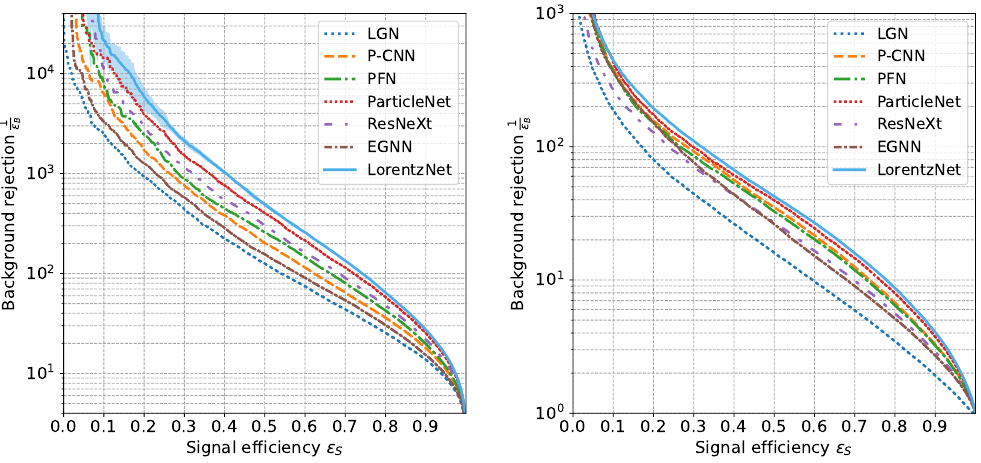
Figure 2 . A comparison of ROC curves between LorentzNet and other algorithms on top tagging dataset (left) and quark-gluon dataset